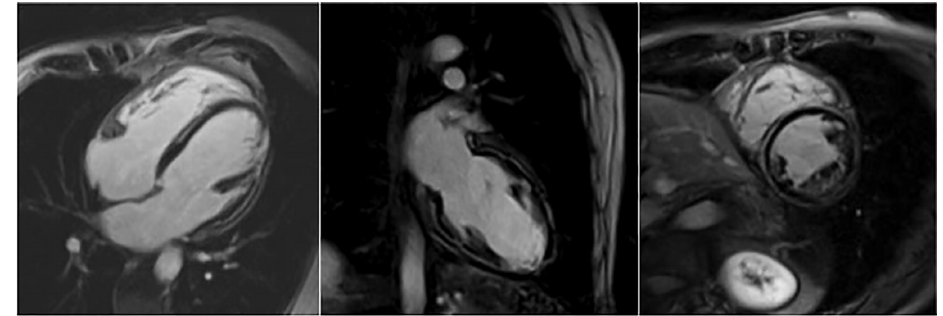
Figure 3. CMR (2014): LGE images (4-chamber, 2-chamber, and short axis views) showing the diffuse intramyocardial and epicardial distribution of fi brotic